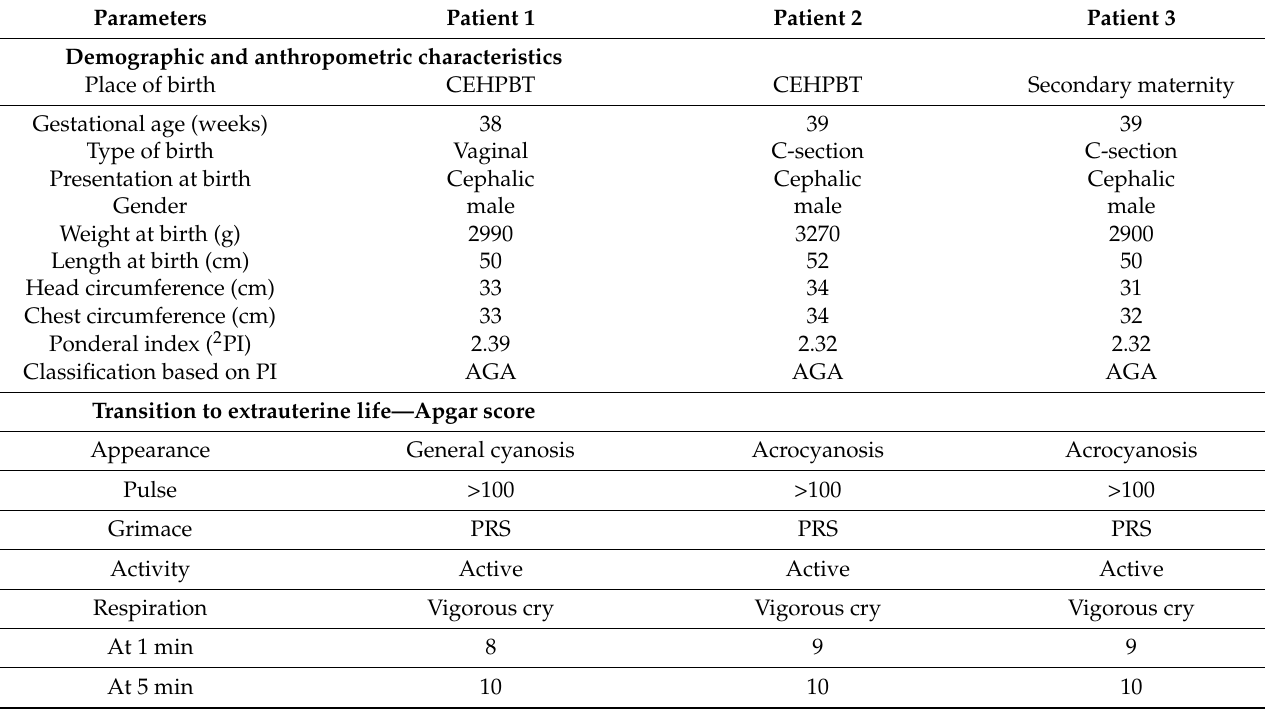
Table 1. Characteristics of the